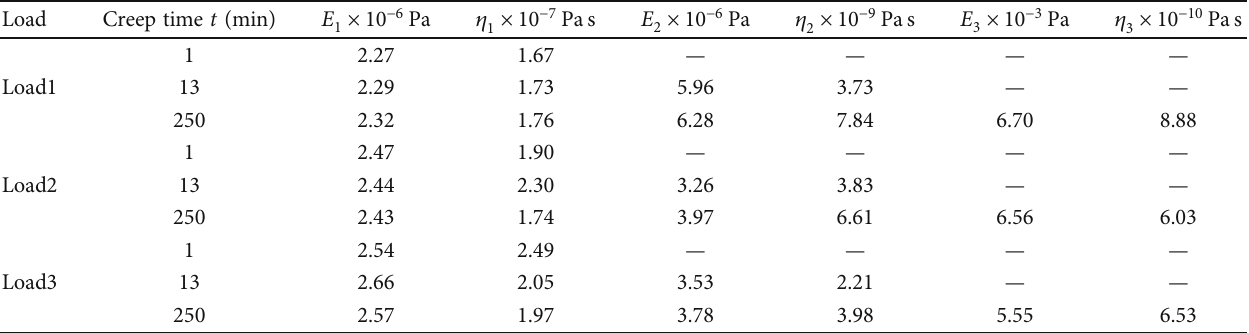
Figure 7: Creep data fi tted to Equation (12) with loads1-3 for speci fi ed creep time: (a) t The dotted line and solid line represent the experimental and the model- fi tted data, respectively. The red, black, and purple lines represent load1, load2, and load3, respectively. Table 2: Fitted values of the model parameters with di ff erent stresses for creep durations 1 min, 13min, and 250 min. Load Creep time t